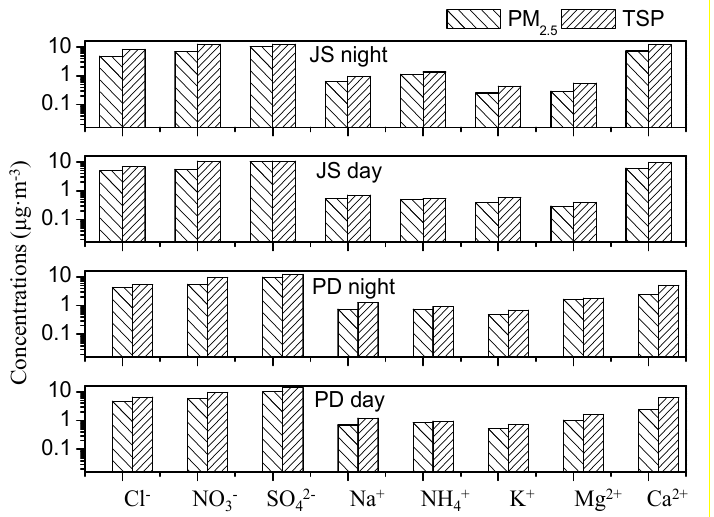
Figure 3. The major ions concentrations in daytime and nighttime for PM 2.5 and TSP at Jinshan (JS) and Pudong (PD).